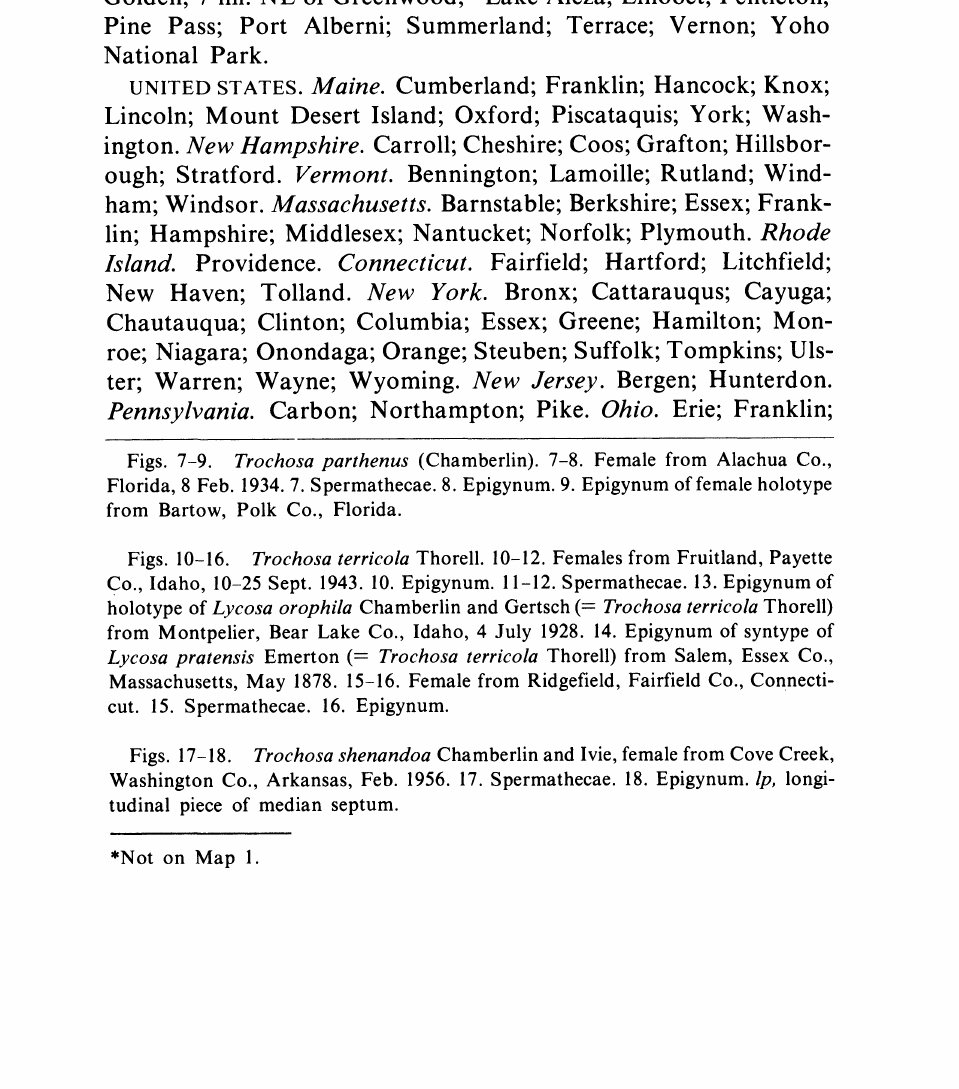
Figs. 17-18. Trochosa shenandoa Chamberlin and Ivie, female from Cove Creek, Washington Co., Arkansas, Feb. 1956. 17. Spermathecae. 18. Epigynum. lp, longi- tudinal piece of median septum. *Not on Map